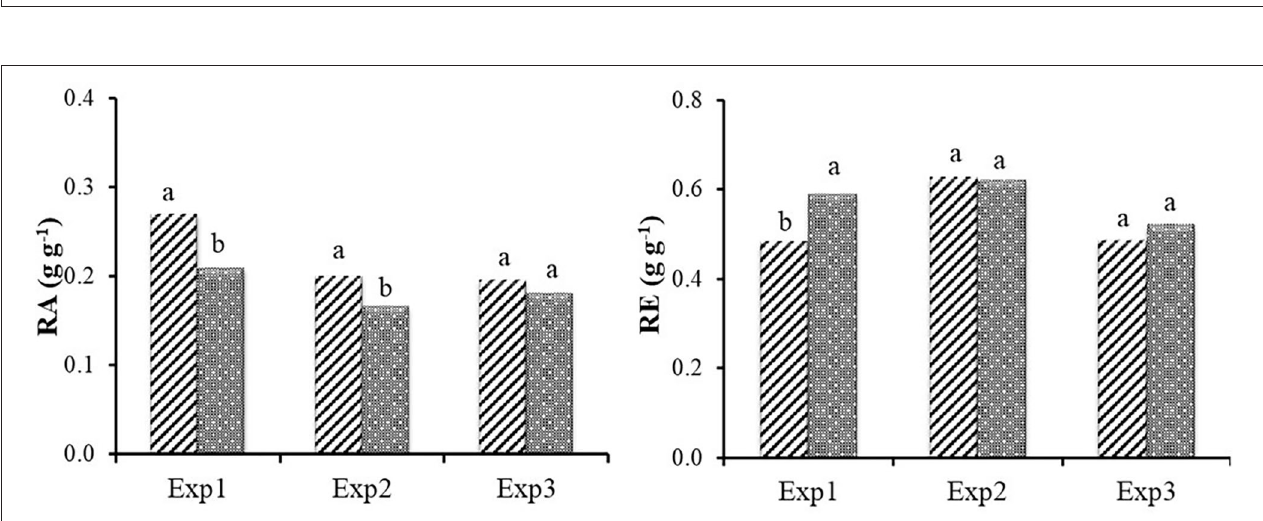
FIGURE 8 | Reproductive allocation (RA) and Reproductive effort (RE) at the final harvest for the three experiments in relation to the resistance status (S and R ). Different letters indicate significant differences ( P < 0.05) according to Fisher’s LSD test.